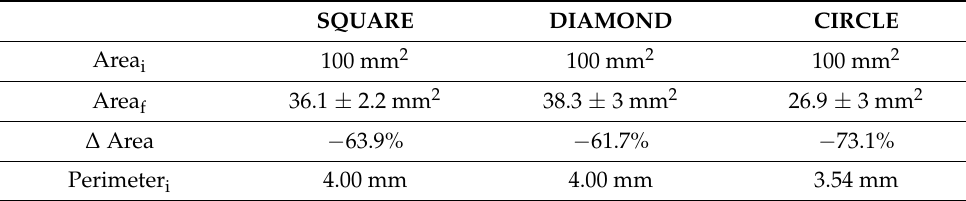
Figure 1. Wound-induced hair follicle neogenesis occurred in the center of all wound shapes. ( a ) Full-thickness 1 cm 2 square, diamond, and circle wounds were created on the dorsum of p21 mice. ( b ) Summary of healed wound shapes at PWD 28 (length, anterior-posterior axis, width medial- lateral axis). ( c ) ALP staining identified regenerative dermal papillae at wound centers of square (left), diamond (center), and circle (right) (red line; wound edge, green line; WHIN area). ( d ) Quantification of WIHN, total area, and regenerative area at PWD 28 ( n = 6. *; p < 0.05, **; p < 0.01) . Table 1. Dimensional analysis of wound geometries during wound-induced hair follicle neogenesis at PWD 28. ImageJ was used to calculate initial and final wound measurements. The circle wound exhibited the greatest reduction in healed wound area ( − 73.1%). There was no significant difference between the square and diamond wounds for healed wound area. The circle exhibited the shortest average final wound length (6.21 mm) and width (4.37 mm) ( i ; initial, f ; final, ∆ ; change% = (final—initial)/final × 100%, data represented as mean ± SEM, ( n =